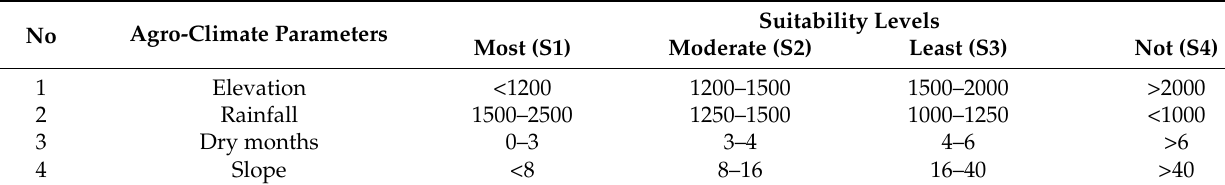
Table 3. Criteria used to map banana suitability.